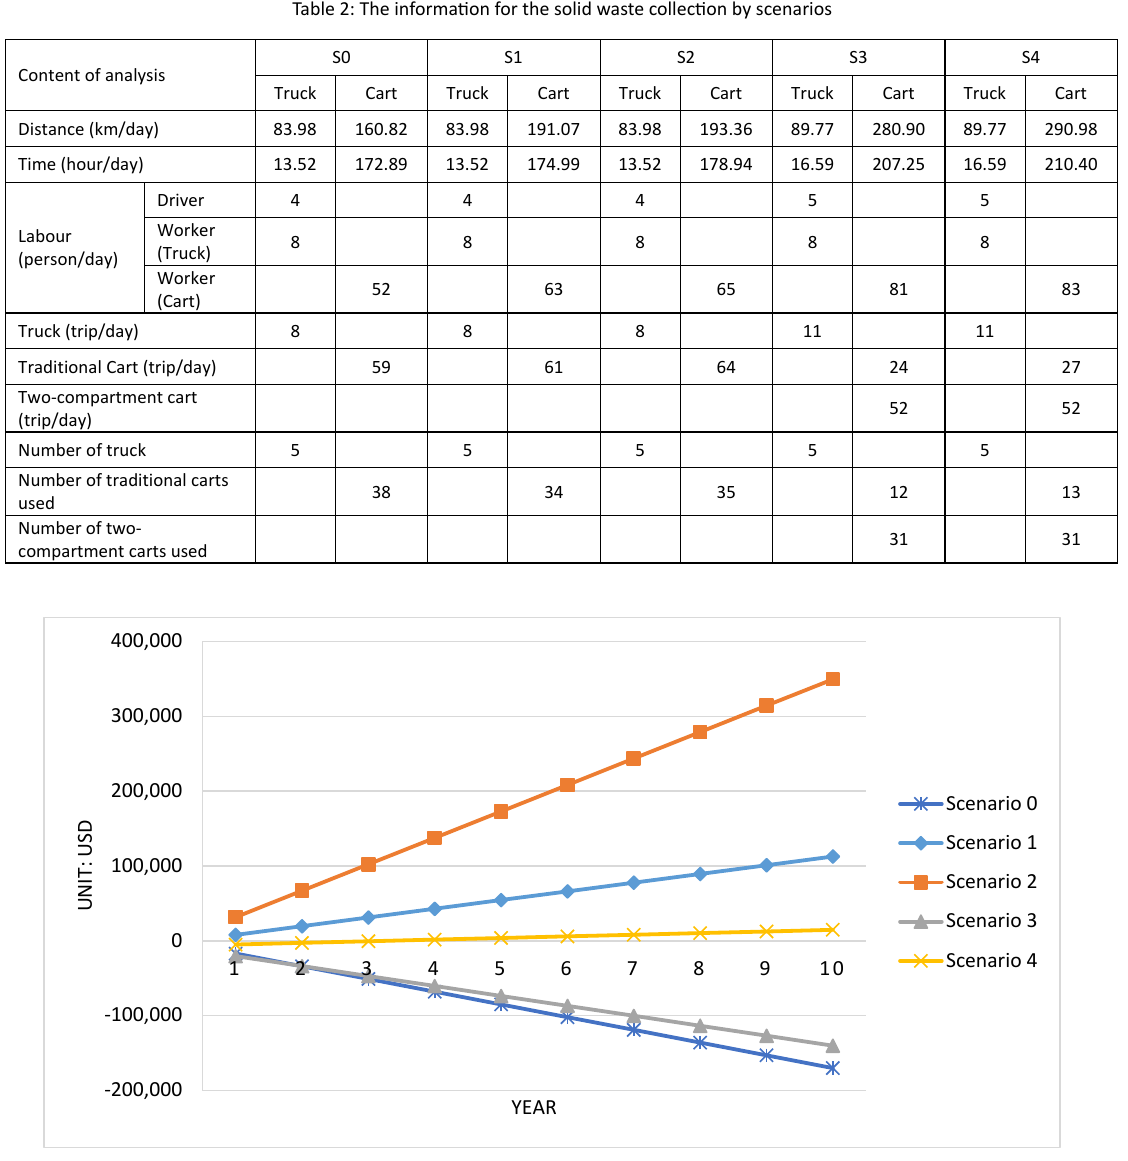
Fig. 10: Economic assessment by scenarios